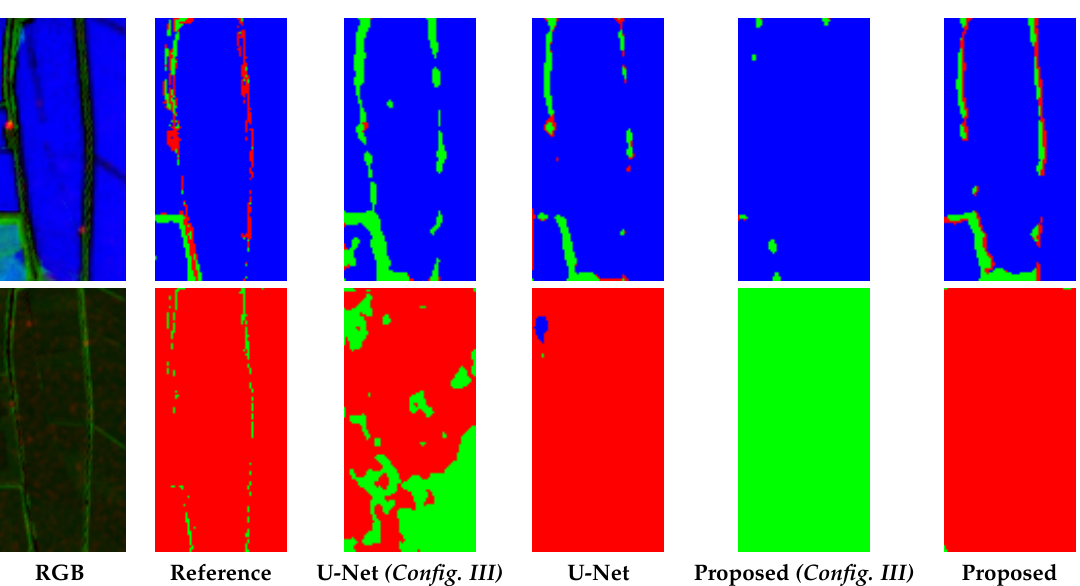
Figure 8. Zoomed details of segmentation results. In the first column, a false colour images (R: VH, G: NDVI, B: MNDWI) is shown; in the other columns, the segmentation maps obtained with the methods under comparison are depicted. In all the segmentation maps green, red and blue pixels represent Vegetation, Bare Soil and Water, respectively. With (Config. III) we consider the dual polarization configuration both for the U-Net and the proposed